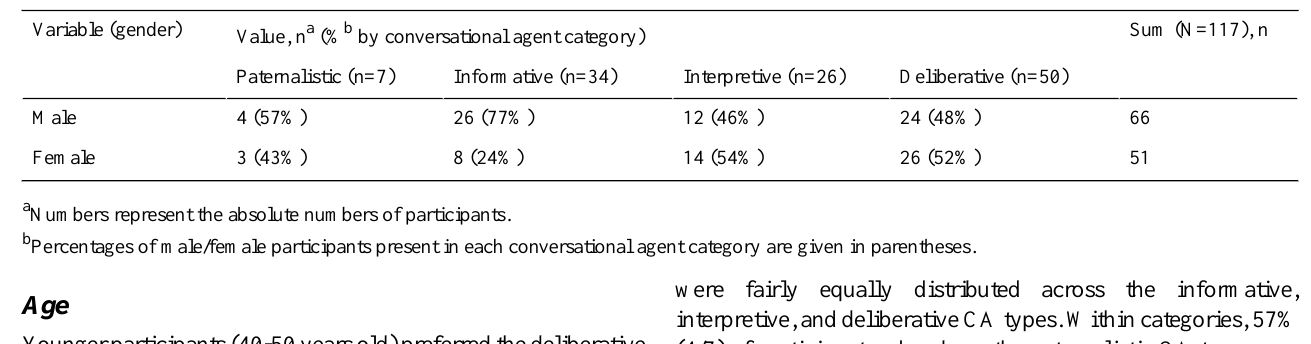
Table 2. Conversational agent preferences by gender.